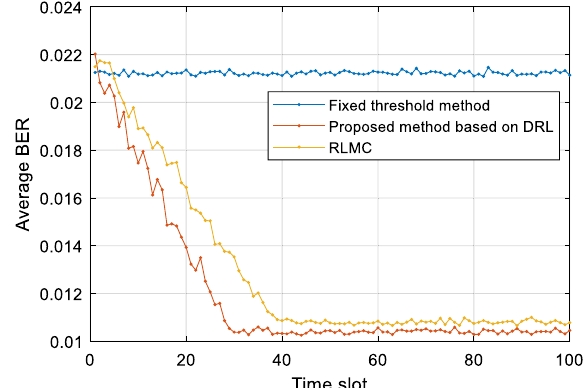
Fig. 16 Average BER of each time slot in simulated experiments